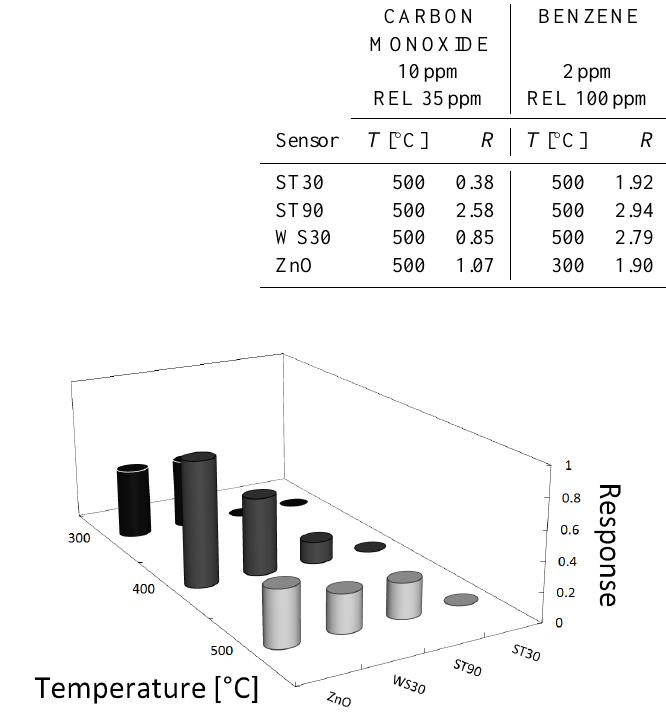
Figure 10. Responses of the sensors to 4ppm of NO at three di ff er- ent